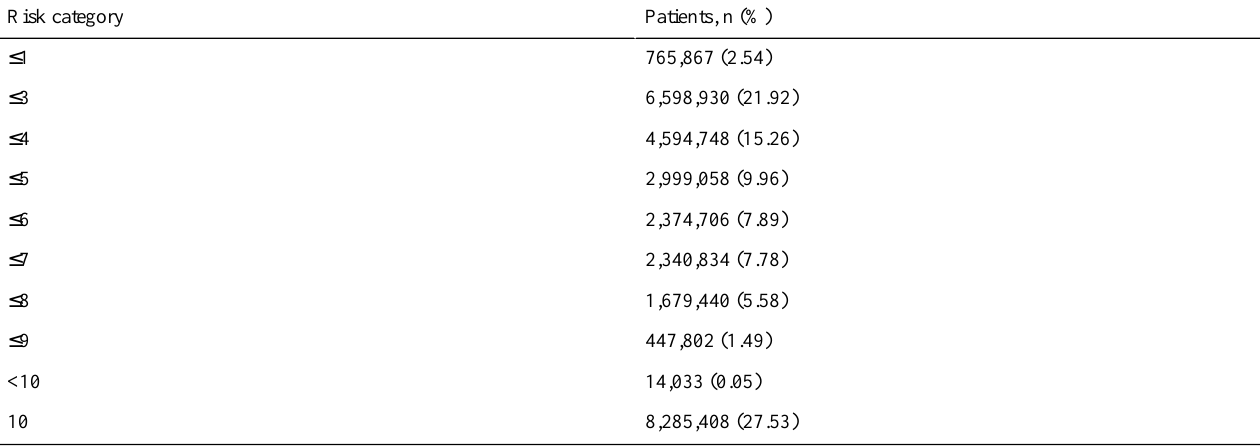
Table 2. Risk category summary (N=30,100,826).